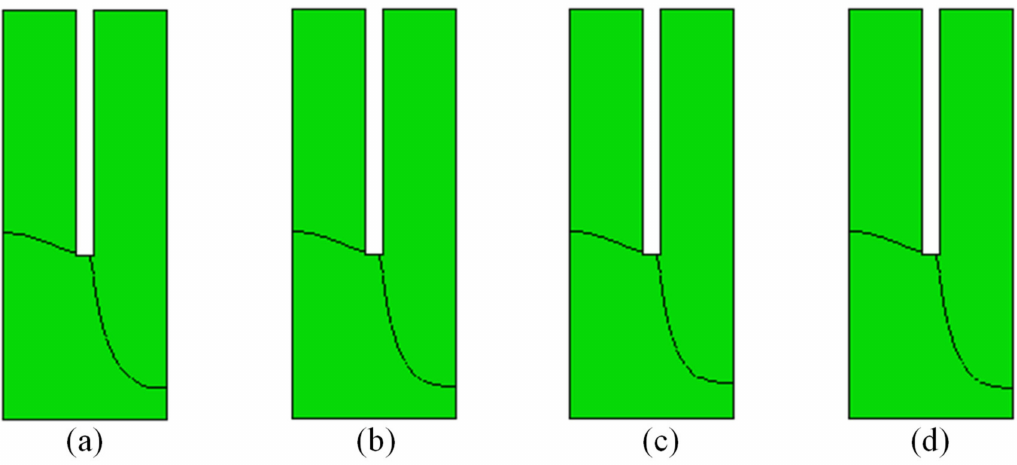
Figure 10. Fracture geometries at different percentages of velocity variation. ( a ) 0%, ( b ) − 13%, ( c ) − 20%, ( d ) −